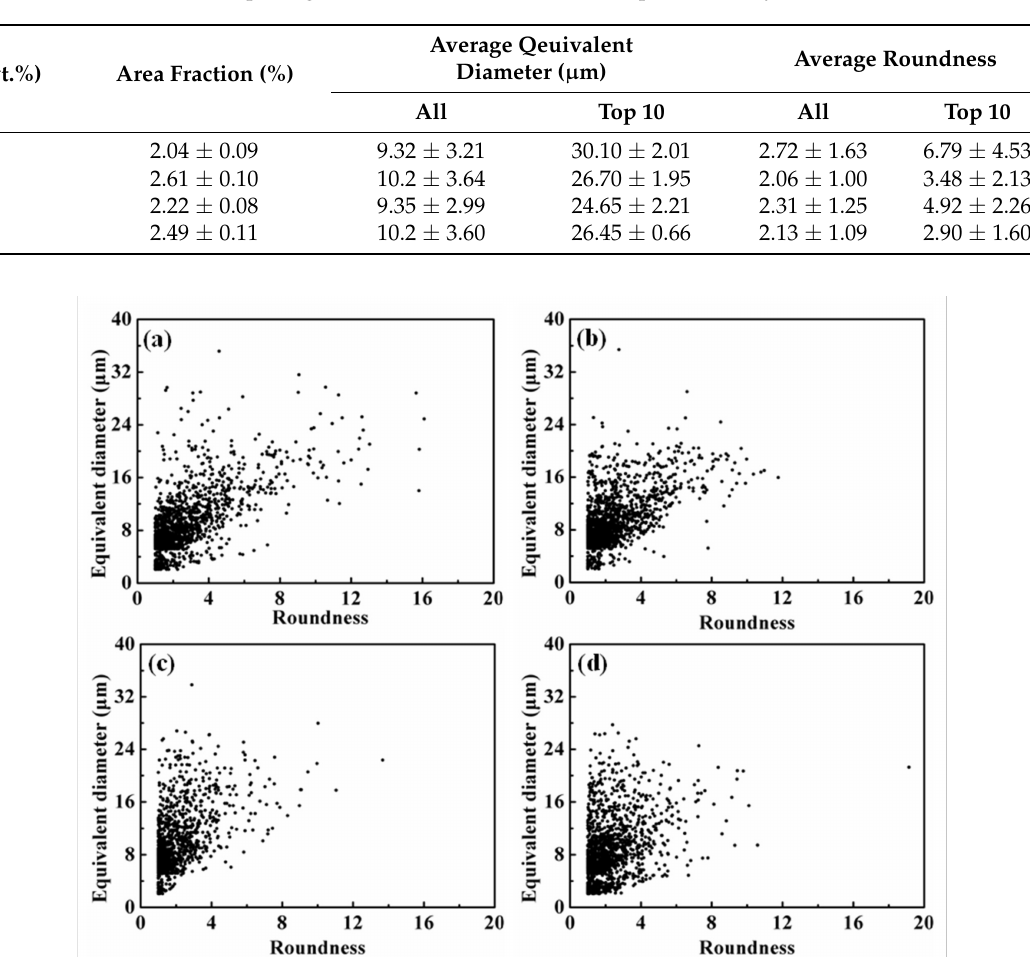
Figure 3. The relationship between the equivalent diameter of the iron-rich phase and its roundness with different Fe content: ( a ) 0.8%; ( b ) 1.2%; ( c ) 1.8%; ( d )